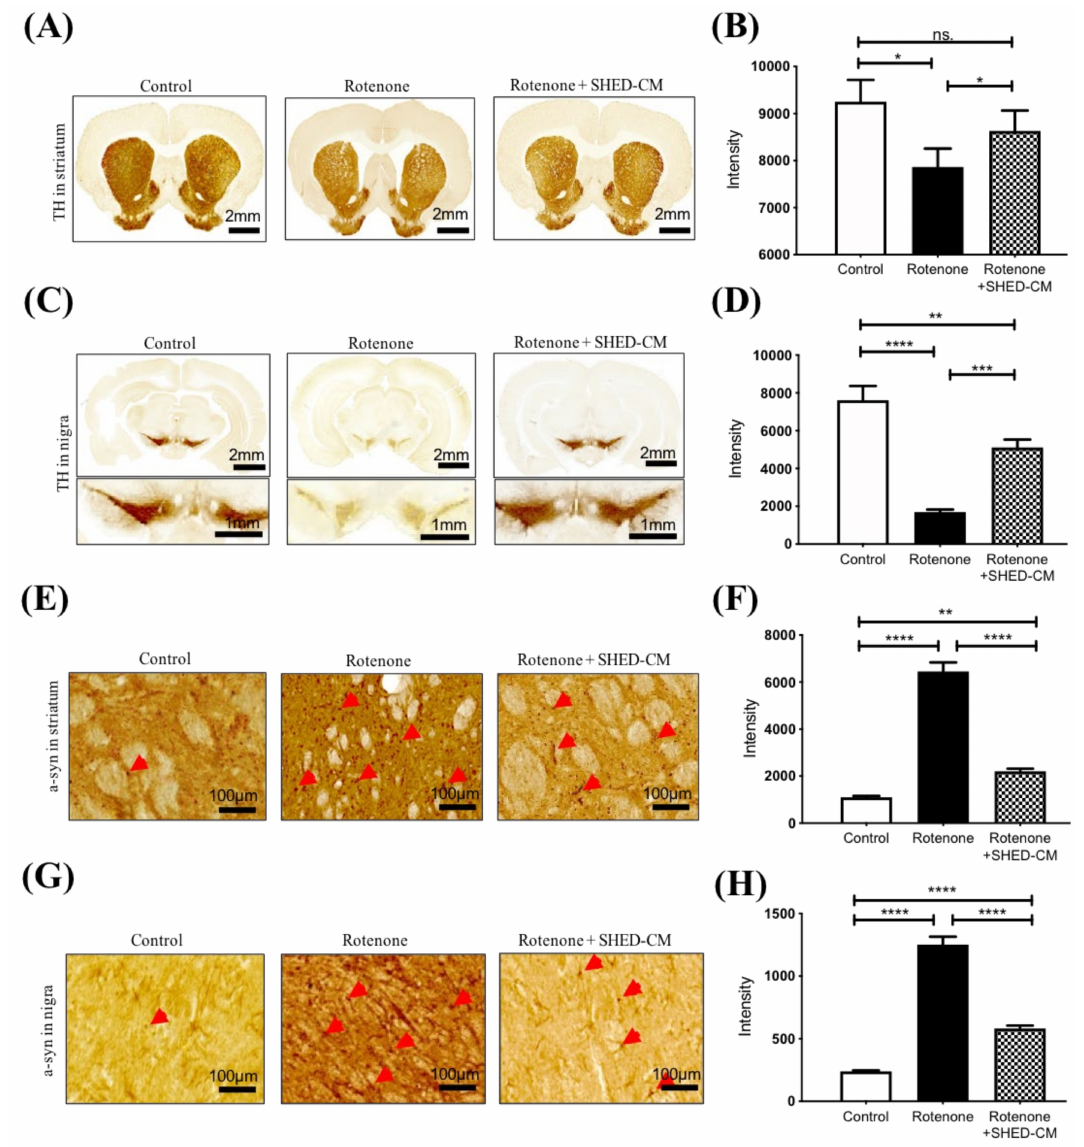
Figure 2. Amelioration of PD pathological features by SHED-CM in di ff erent brain areas from rotenone-induced PD rats. Immunohistochemistry showed the lateral ventricle size and tyrosine hydroxylase (TH) expression in the striatum ( A ) and substantia nigra ( C ) from rotenone-treated PD rats with indicated treatment. Quantification of TH expression in the striatum ( B ) and substantia